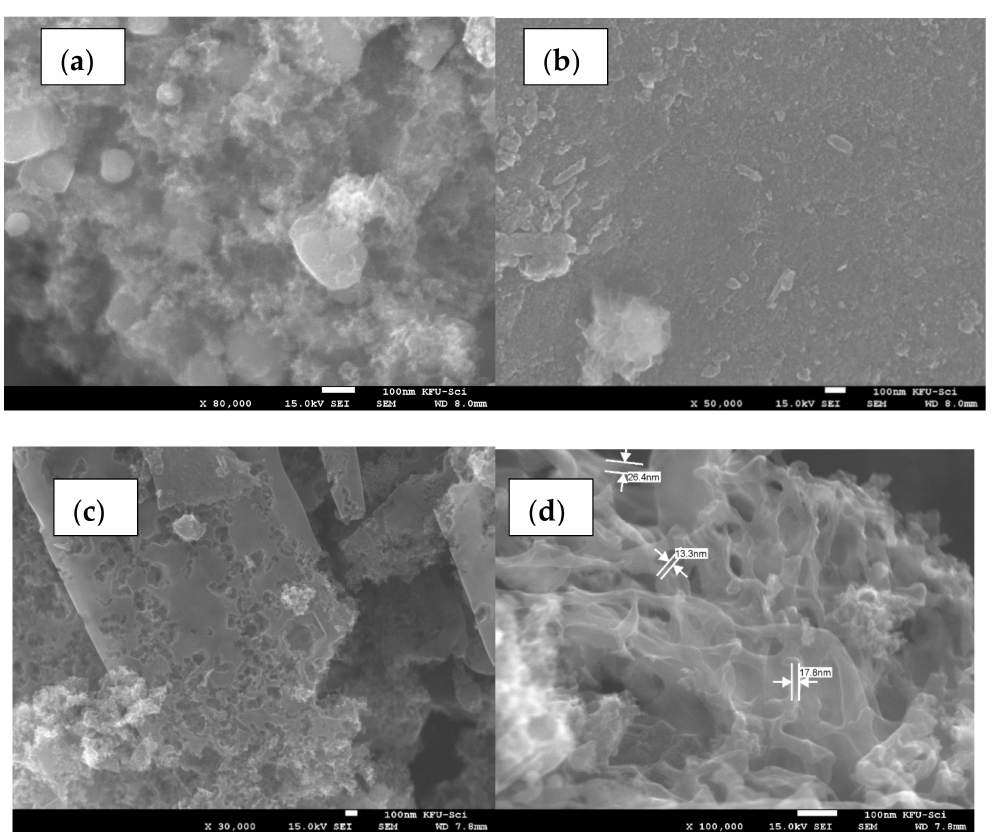
Figure 1. SEM analysis of nancomposites; ( a ) SEM of (1), ( b ) SEM of (2), and ( c ) SEM of (3) and ( d ) SEM of